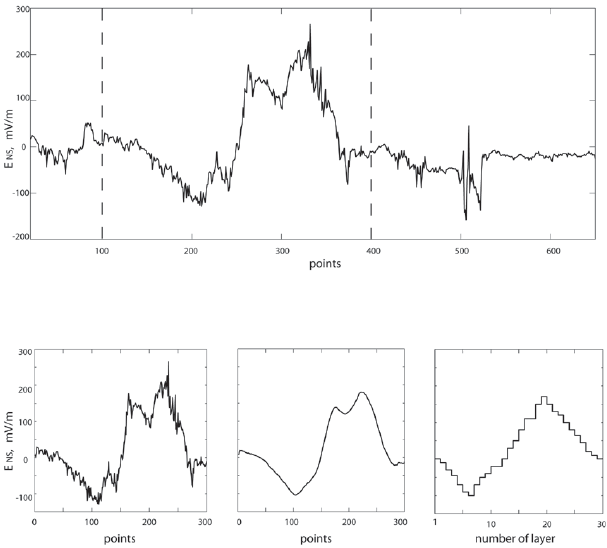
Fig. 2. (top) An “isolated” electric field structure selected to be eval- uated by the IEDD theory. The dashed lines mark the borders of the structure; (bottom) the same structure being smoothed and approx- imated by a piecewise constant